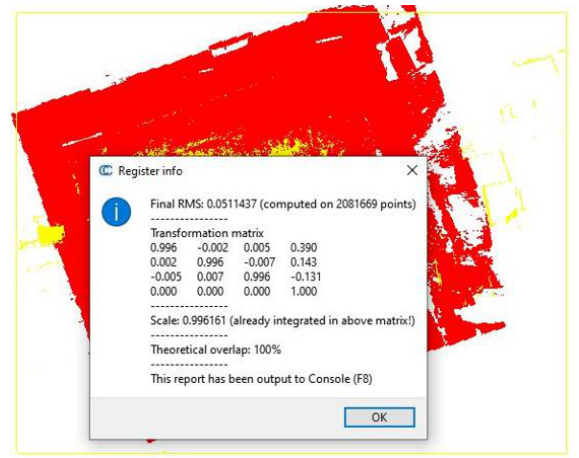
Figure 7. On the figure 7 there is a comparison of BLK360 point cloud with a point cloud derived from DJI Mavic Pro drone. It is clear, that both laser scanned point clouds are almost identical, but the point cloud from the DJI Mavic Pro is distorted. The repeated second flight done by the DJI Mavic 2 was already fine and correlated with data from the laser scanners.